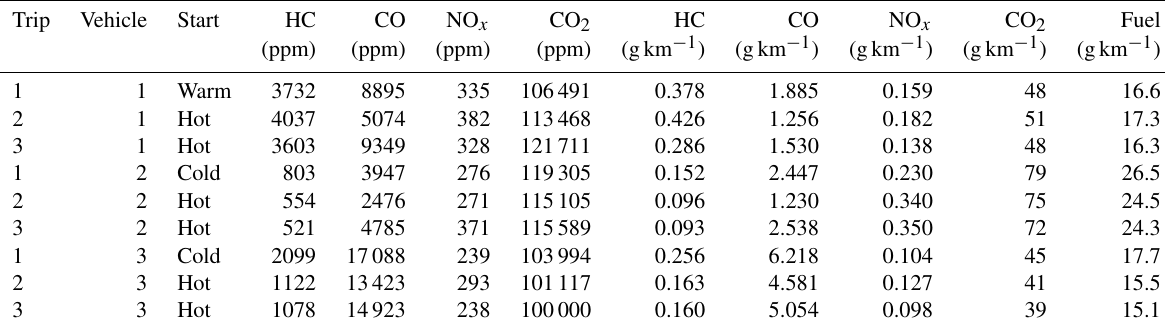
Table 7. Exhaust concentrations (average), real-driving emissions factors, and fuel consumption during on-road trips. Trip